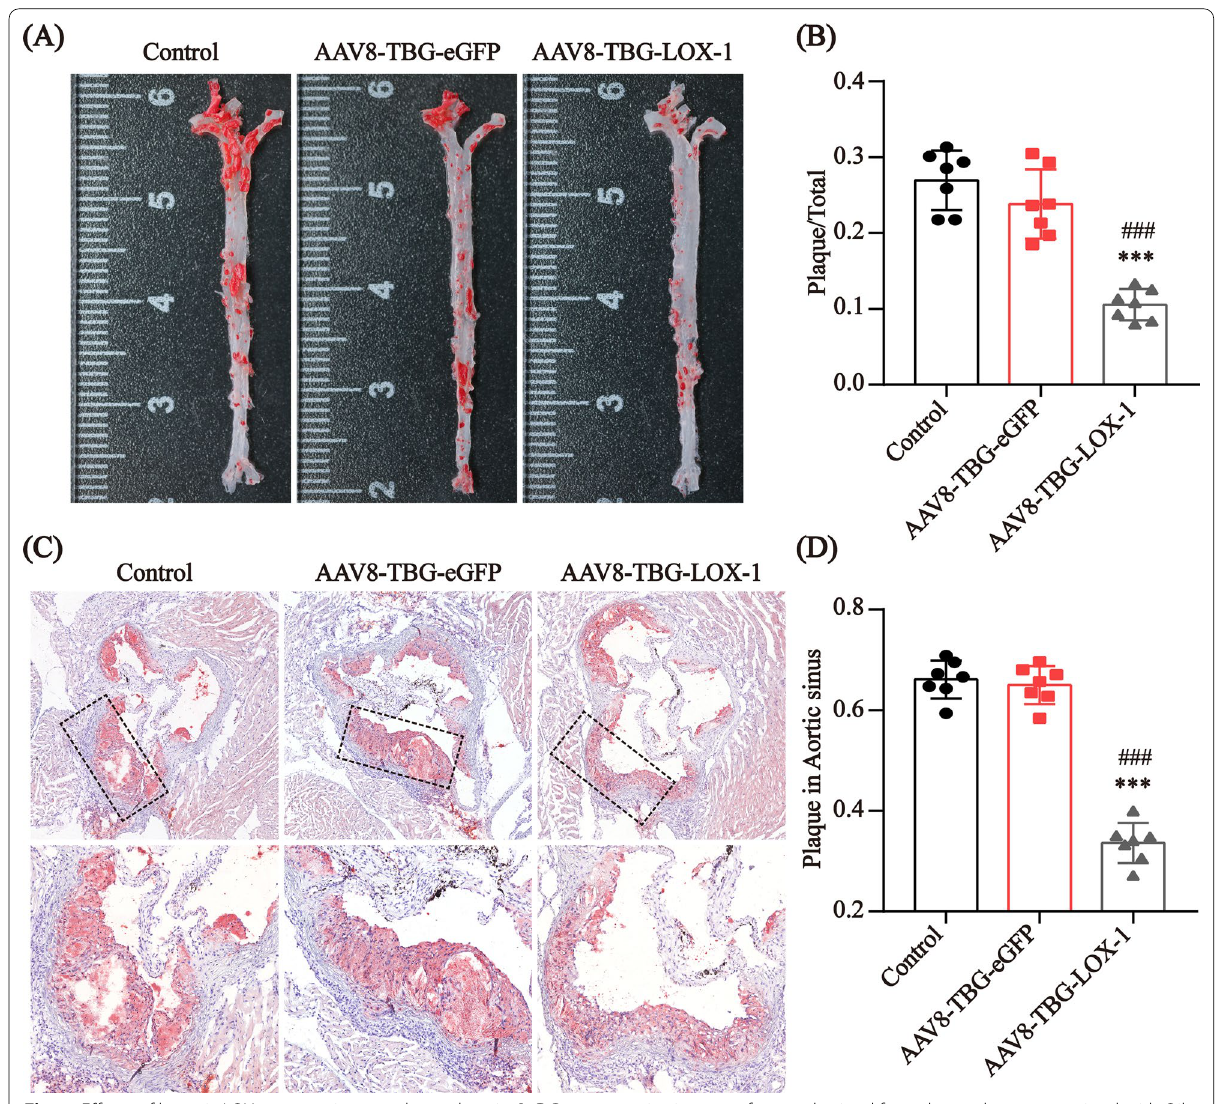
Fig. 5 Effects of hepatic LOX-1 expression on atherosclerosis. A , B Representative images of aorta obtained from the study groups stained with Oil red O ( A ). The percentage of the plaque area in the aorta is presented among the indicated groups (n 7) ( B ). C , D Representative images of aortic = root sections obtained from the study groups stained with Oil red O ( C ). The percentage of the plaque area in the aortic root is presented among the indicated groups (n 7). D Values are expressed as mean SD. ***P < 0.001 compared with the control group. ### P < 0.001 compared with the = ± eGFP